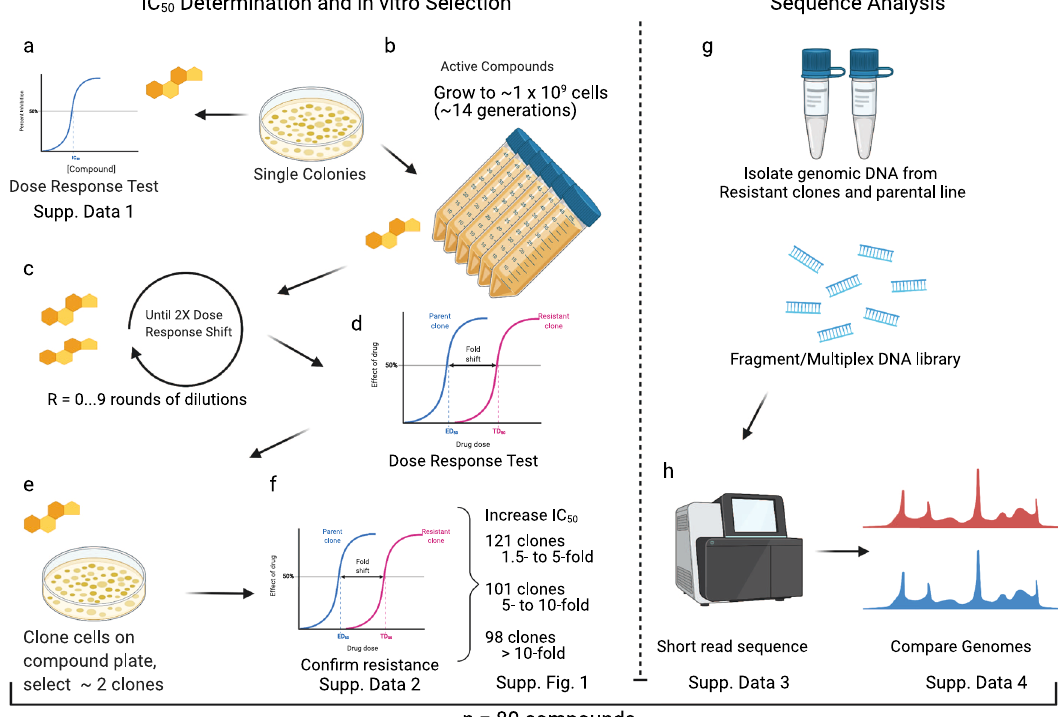
Fig. 2 Generation of resistant yeast strains using a stepwise method of compound exposure. a To determine the degree of growth inhibition of small molecules, cultures derived from single colonies of the ABC 16 -Green Monster strain (GM) were exposed to various drugs and the IC 50 s determined. b For in vitro selections single colonies of GM were picked and grown to saturation in YPD media. 50 μ l cells of a saturated culture (OD 600 = 1) were inoculated into 50 mL tubes containing 20 mL of YPD media with a small-molecule inhibitor and grown until saturation. The starting drug concentration was the pre- determined IC 50 . c Upon reaching saturation cultures were diluted (1:400) into fresh media with increasing drug concentrations. d Development of resistance was evaluated through regular IC 50 determinations. e Once cultures showed at least a 2-fold shift in IC 50 single clones were generated by plating an aliquot of the resistant strain onto compound-containing YPD plates. f Two independent clones were picked and the IC 50 shift con fi rmed. IC 50 values were calculated by subtracting OD 600 nm values at time 0 h from time 18 h. Nonlinear regression on log([inhibitor]) vs. response with variable slope was performed using GraphPad Prism. Cycloheximide was used as a negative control. g DNA from clones deemed to be resistant (through a combination of fold shift of IC 50 and p -value) was isolated and their whole-genome analyzed. h The genomes of the drug-naïve parents and the drug-resistant clones were compared and allele differences between these two clones were determined. Data from all in vitro evolutions was analyzed in great detail. To further validate the potential resistance of the identi fi ed mutations allelic replacement of these SNVs into the parental line through CRISPR-Cas9 was performed. Graphics created with Biorender.com under BioRender ’ s Academic License